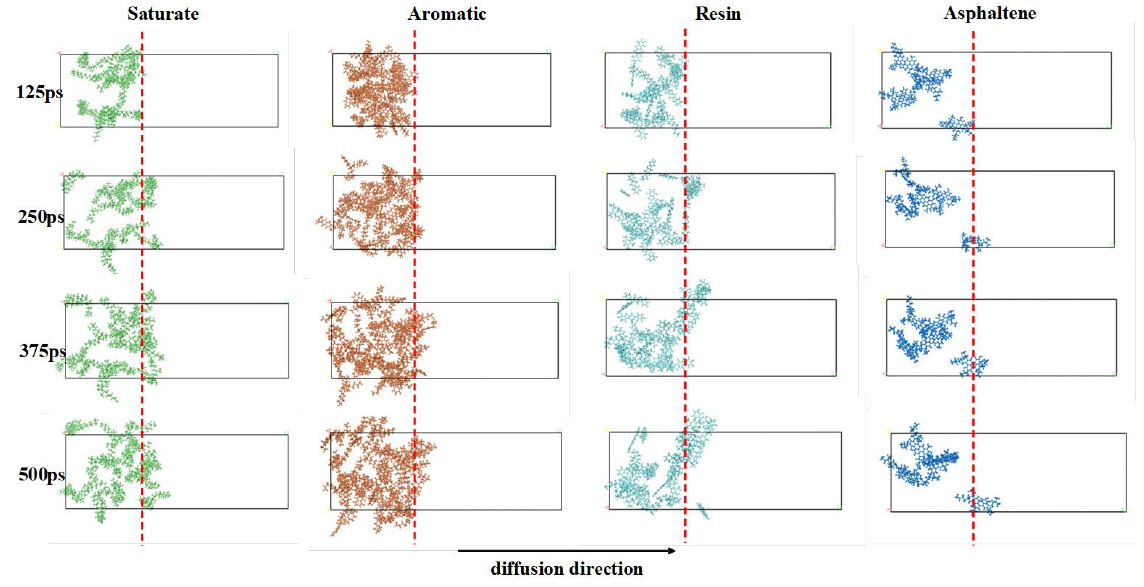
Figure 17. Di ff usion process (virgin asphalt–RAM). Figure 17. Diffusion process (virgin asphalt–RAM).